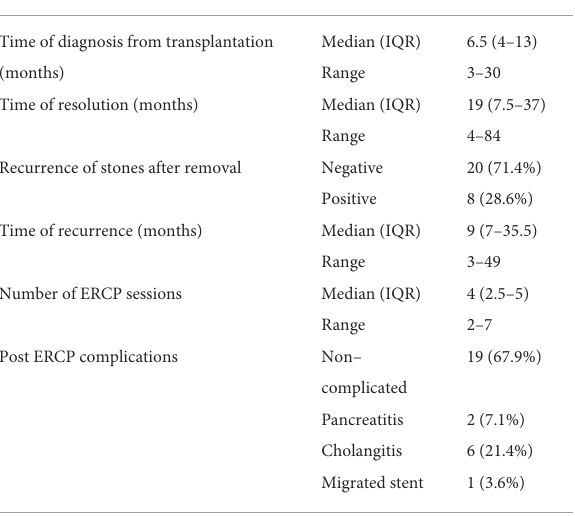
TABLE 5 Descriptive data regarding the stone